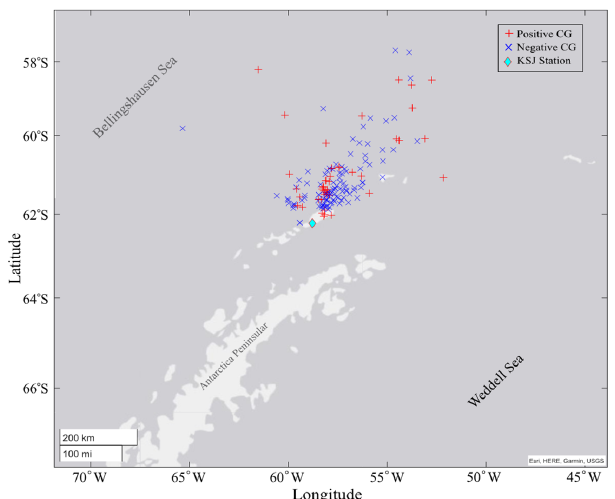
of lightning strikes.